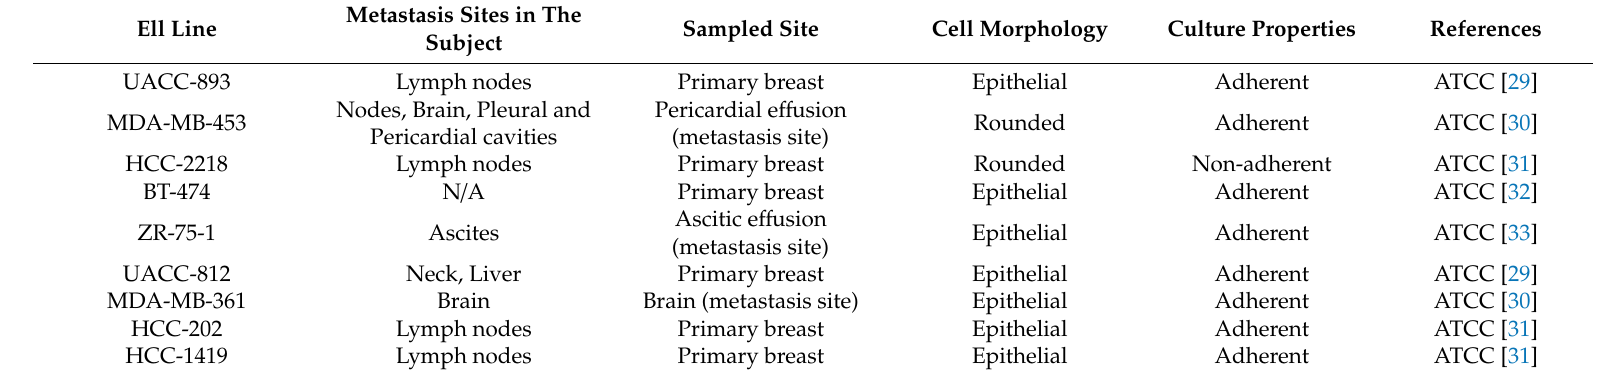
Table 1. Characteristics of Nine HER2-positive Breast Cancer Cell Lines.